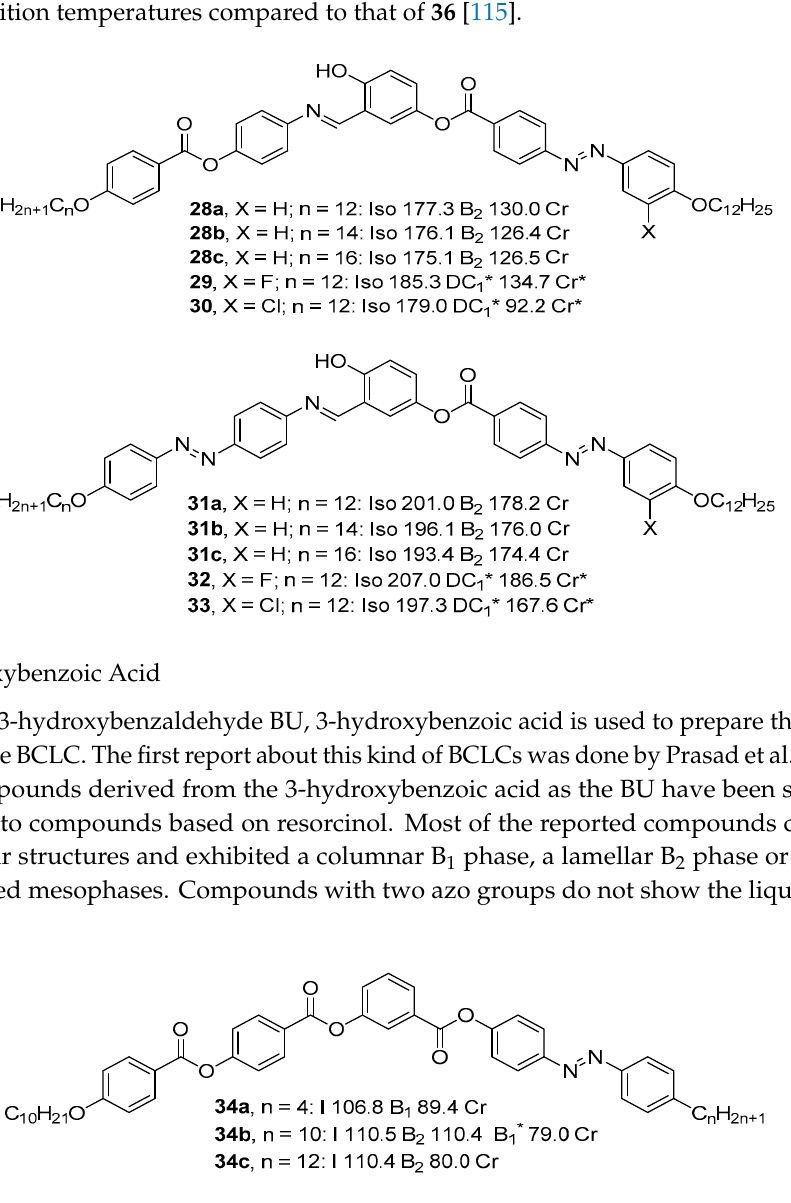
Figure 7. The optical texture of DC 1 * obtained for compound 25b at 170 °C: ( a , c ) between the uncrossed polarizers by an angle of about 8° and ( b ) between crossed polarisers; ( d – f ) textures of DC 2 * obtained under the same conditions as observed ( a – c ), at 158 °C; ( g – i ) textures of Cr* obtained at the room temperature